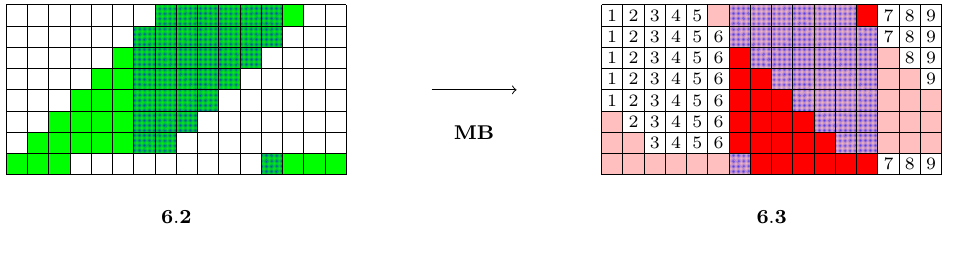
Figure 9: Fixed bytes and lists of